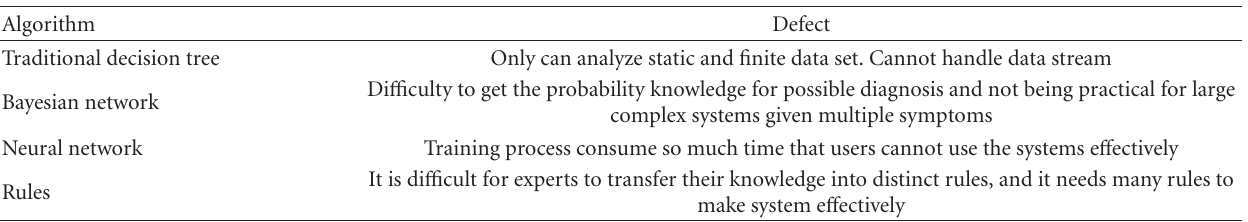
Table 2: Defects of traditional